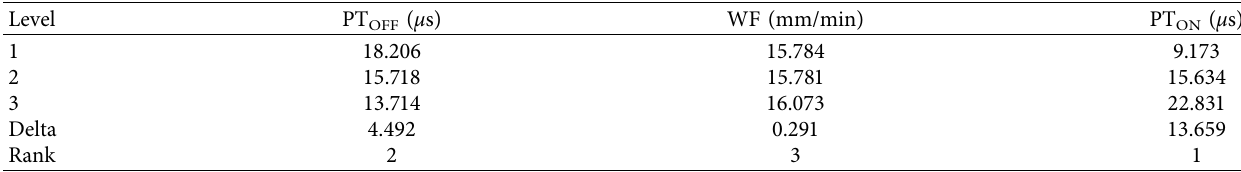
Figure 20: Main effects plot for SN ratios. Table 10: Response table for menas for MRR.